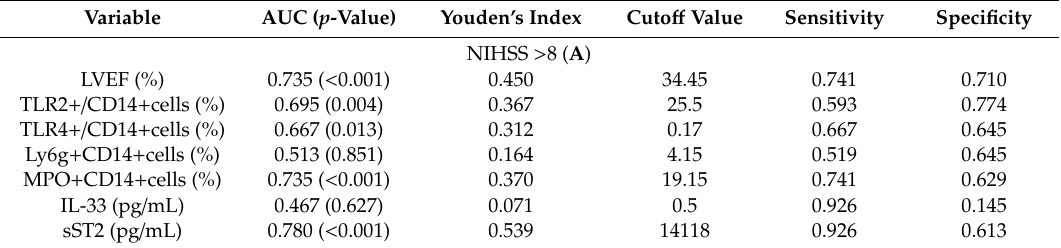
Table 3. Area under the curve (AUC) and Youden’s index for determining cuto ff value of variables based on NIHSS and